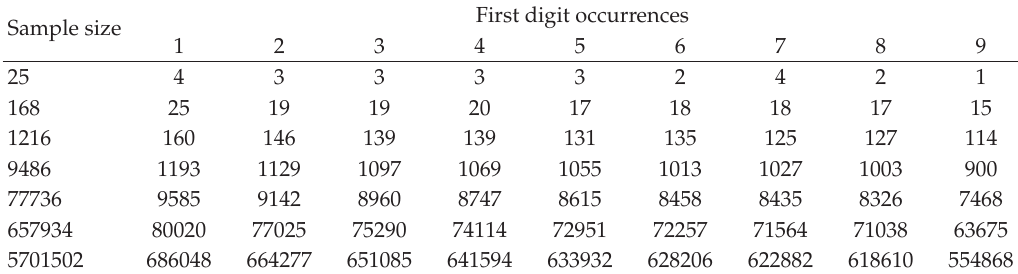
Table 4: First digit distributions of prime number sequences with optimal cuto ff .